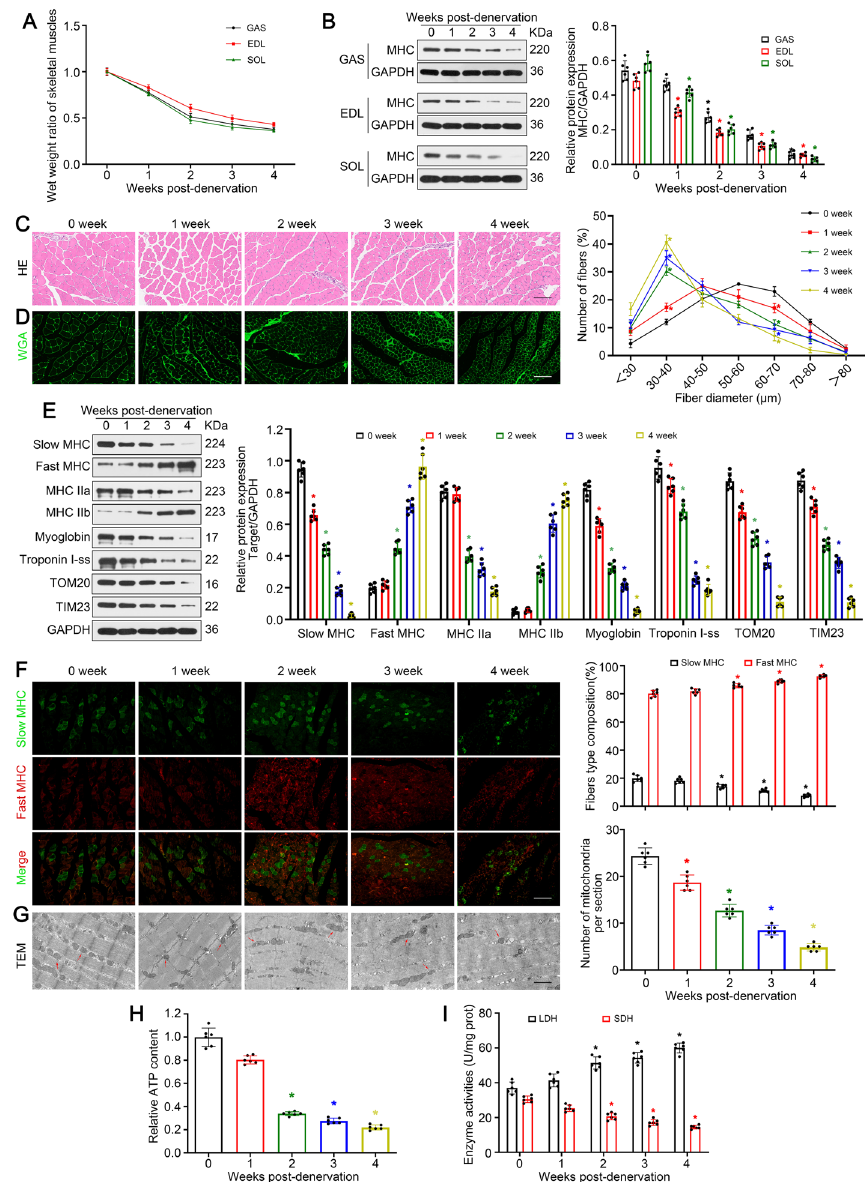
Fig. 1 Denervation led to skeletal muscle atrophy and slow-to-fast myofiber shift. A Wet weight ratio (the weight of the operational side divided by the contralateral side) of GAS, EDL, and SOL at indicated timepoints post-denervation. B Western blot analysis of the dynamic changes of MHC protein expression after denervation. C , D Analysis of gastrocnemius fibers diameter by H&E and immunofluorescence staining. Scale bar, 50 μm. E Western blot analysis of proteins related to muscle fiber type. F Immunofluorescence analysis of the fiber type composition in denervated GAS. Scale bar, 50 μm. G Microstructure of GAS. Red arrows indicate mitochondria. Scale bar, 2 μm. H , I Relative ATP content and metabolic enzyme activity (LDH and SDH) in GAS at different timepoints post-denervation. Data presented as mean standard deviation (SD). n 6. * P < 0.05 ± = versus control (week